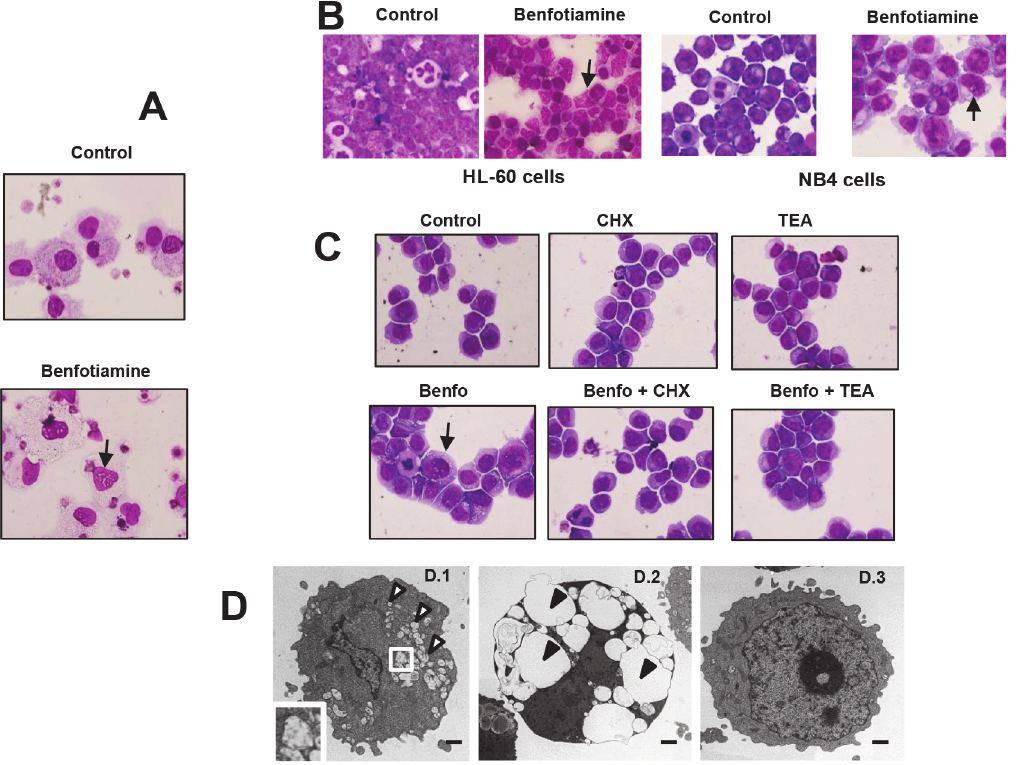
Fig 2. Benfotiamine induced cytoplasmic vacuolization in myeloid leukemic cells. Primary leukemia cells BM-S-blasts (A) were cultured for 72 hours in the presence or absence of benfotiamine (100 μ M) and subjected to Giemsa staining. Representative results of three independent experiments are shown. (B) HL-60 and NB4 cells were cultured for 72 hours in the presence of benfotiamine (100 μ M) and then subjected to Giemsa staining. Arrows indicate the presence of cytoplasmic vacuoles. (C) HL-60 cells were cultured in the presence of 0.25 μ g/ml of cycloheximide (CHX) or tetrathylammonium (TEA) for 2 hours, cultured for an additional 12 hours with or without 100 μ M benfotiamine (Benfo) and stained with Giemsa. A representative result of three independent experiments is shown. (D) Transmission electron microscopic images of HL-60 cells treated with (D.1, D.2) or without (D.3) benfotiamine. The characteristic signs of paraptosis in benfotiamine-treated cells with massive vacuolization (open arrowheads) are visible. The inset in D.1 is a higher magnification showing mitochondria enlargement. Fig. D.2 shows megavacuoles occupying the cytoplasm of benfotiamine-treated HL-60 cells (closed arrowheads). Fig. D.3 shows untreated HL-60 cells with normal mitochondria architecture and rough endoplasmic reticulum. Bar = 1 μ m.